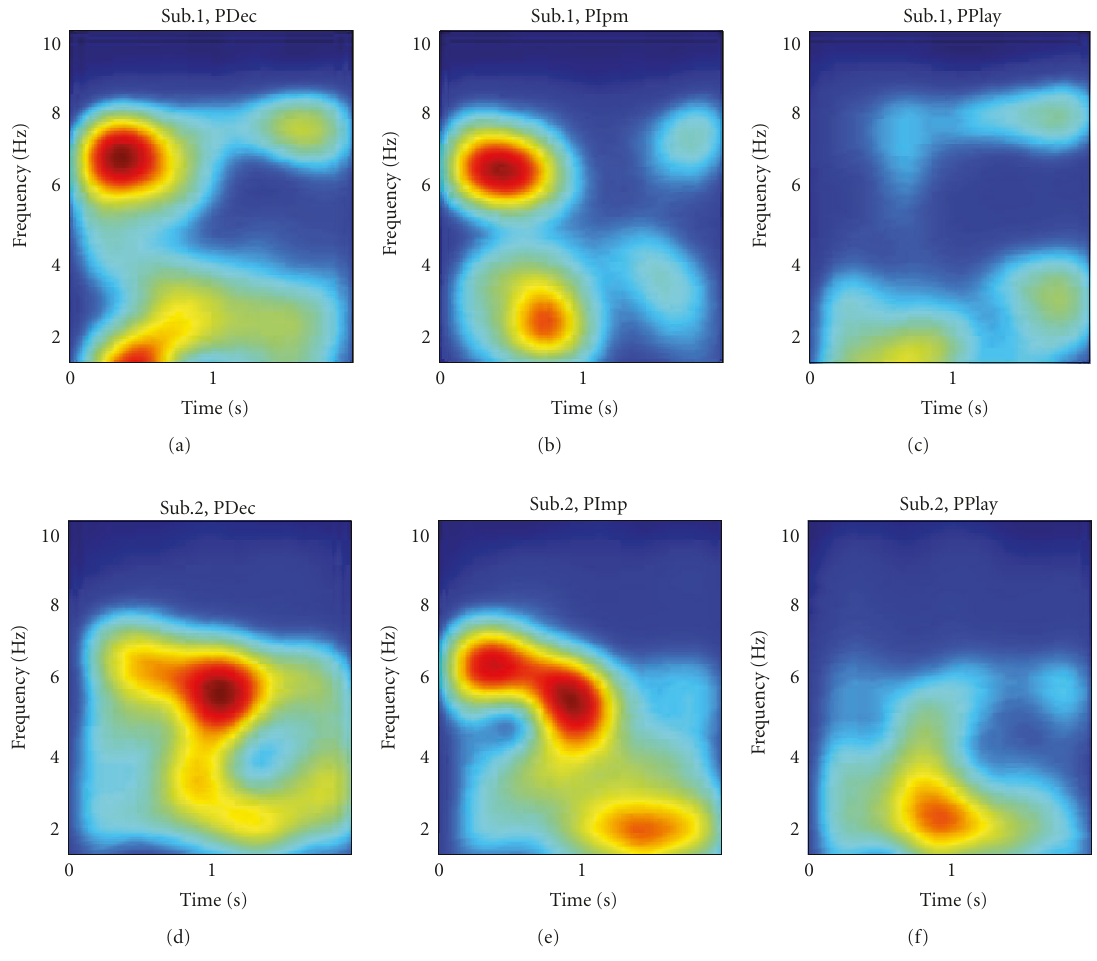
Figure 10: Multitaper spectrogram estimation of induced potentials from Protodeclarative (PDec), Protoimperative (PImp) and neutral parallel play (PPlay) shows, using N = 256, F s = 12, c = 3, and δ = 0 . 05. The number of averaged power responses are for subject 1, 20 and for subject 2,